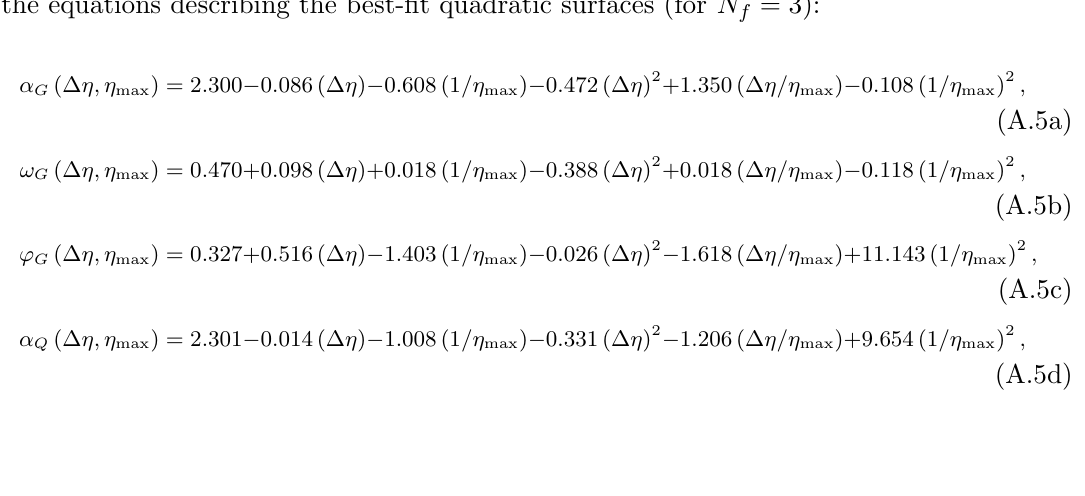
ln j G (0 ; (cid:17) ) j and d 2 ln j Q (0 ; (cid:17) ) j for N f = 3 and N c = 3. Both graphs d(cid:17) 2 d(cid:17) 2